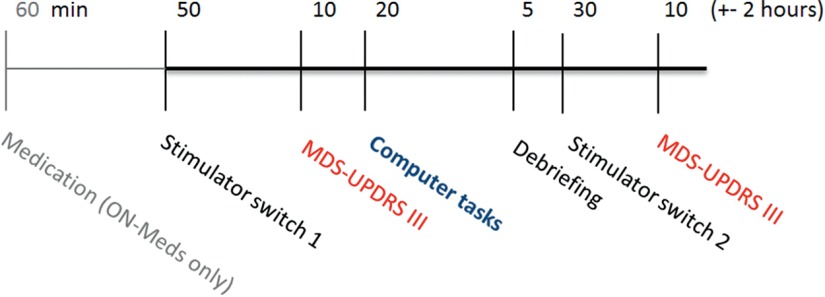
Schematic overview of a session. If patients were tested in the on-medication condition, they received medication (1.5× their regular l-dopa dose) 60 min before DBS was switched off or left on. Patients in the off-medication condition had not ingested dopaminergic medication since the previous evening. At the end of a session, a second MDS-UPDRS-III assessment was conducted in the opposite DBS state to confirm DBS effects within subjects.